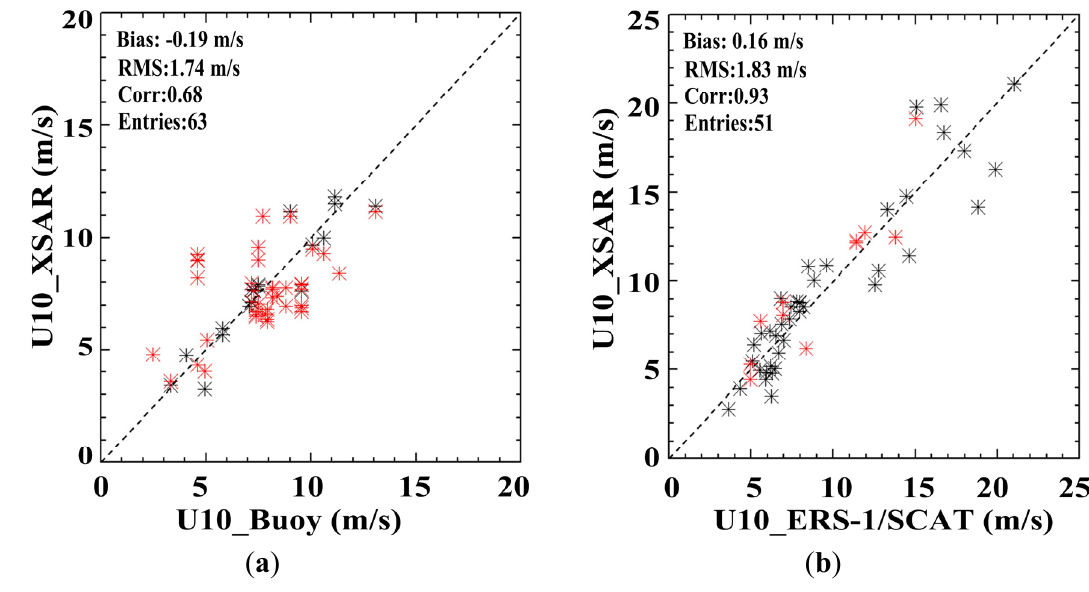
Figure 9. Validation of the SIRX-MOD model through a comparison with ( a ) in situ buoy measurements and ( b ) ERS-1/SCAT measurements. The red signs indicate the collocation distance between the X-SAR data and the buoy or ERS-1/SCAT is less than 100 km. X-SAR data acquired over the Atlantic Ocean on Oct. 6, 1994 at 12:42 GMT are selected to